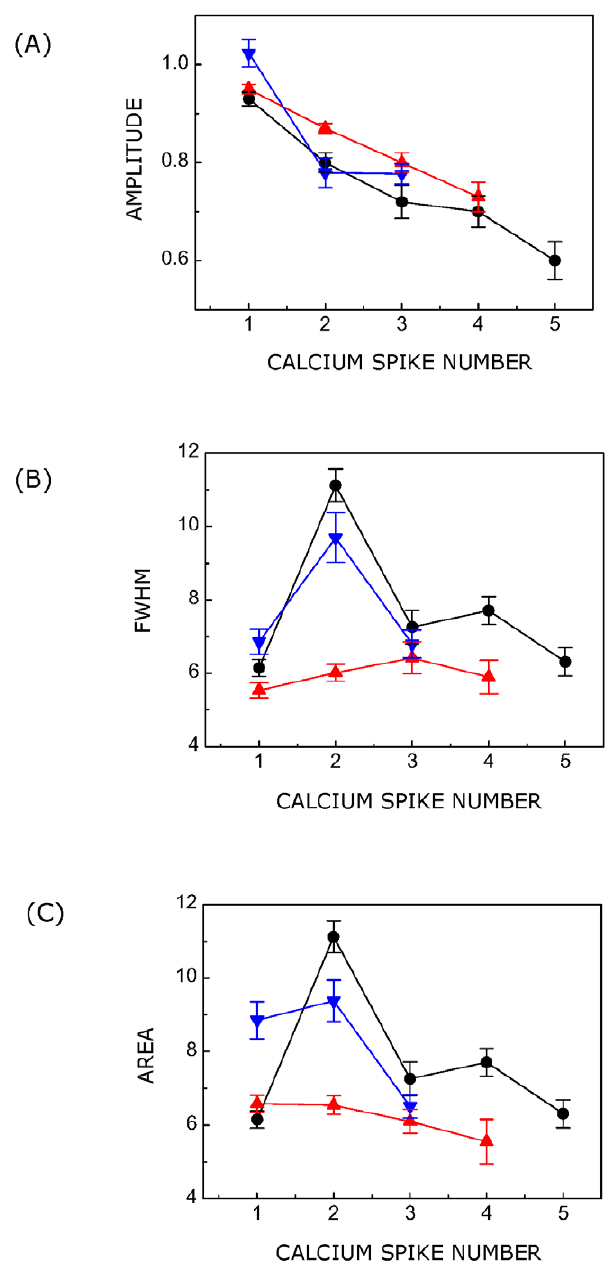
Figure 6. Amplitude, full width at half maxima (FWHM) and area vary for individual spike in a multi-spike response. The amplitude of calcium spike represents the maximum fold change in cytosolic calcium level. The area of calcium spike corresponds to the amount of calcium released in the cytoplasm and FWHM denotes the life span of the calcium spike in the cytoplasm. Panels (A), (B) and (C) show amplitude, FWHM and area for serotonin-induced calcium spikes N (blue triangle), and ATP-induced distinct (red triangle) and overlapping ) calcium spikes, respectively. The temporal profile of calcium ( response was intensity-normalized such that the maximum and minimum (basal) intensities corresponded to values 2 and 1, respectively, before fitting it with a multi-gaussian function. In case of serotonin and ATP-stimulated calcium spikes, R 2 values for fitting of calcium spikes with Gaussian function ranged from 0.92–0.98 and 0.94– 0.99, respectively. Values represent means 6 SEM of more than 50 cells from at least four independent experiments. See Materials and Methods for more details. doi:10.1371/journal.pone.0051857.g006 PLOS ONE |